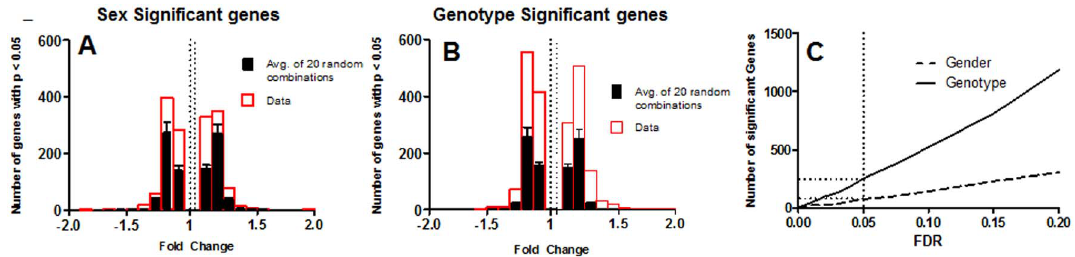
Figure 2. Statistical analysis and validation: Histogram for the number of significant genes and their fold changes from the actual combination of Bead Chips compared to 20 random combinations (p , 0.05) are shown for both (A) sex and (B) Genotype. This shows the number of significantly identified genes in the actual combination is higher than number of false positives expected, even at low fold change. Number of significant genes as a function of FDR value is shown, at every FDR level genotypic variation is larger than the (C) sex variation. When corrected for multiple comparison (FDR) no significant fold changes are identified in any of the random combination until FDR=0.20. Significant genes were calculated using Partek Genomics Suite, using three way ANOVA model on filtered dataset for signal intensity and batch effect (13, 155 probe sets of 25179) and p value , 0.05, corrected for FDR , 0.05.